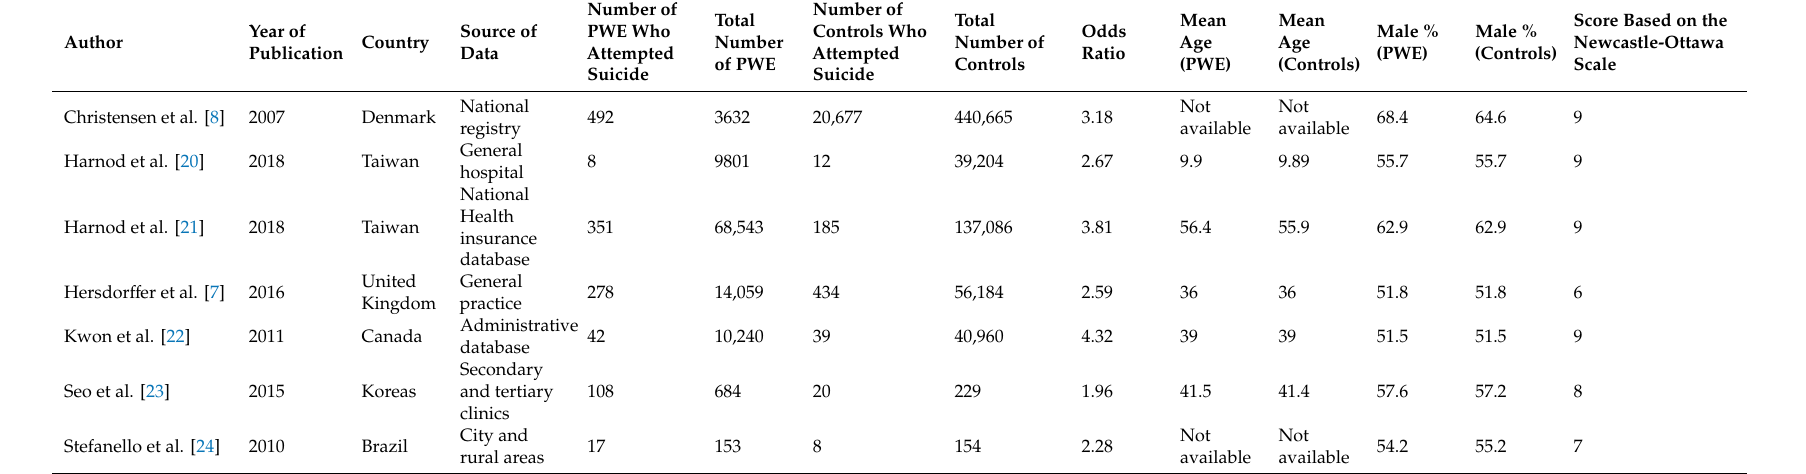
Table 1. Descriptive data of the seven included case-control